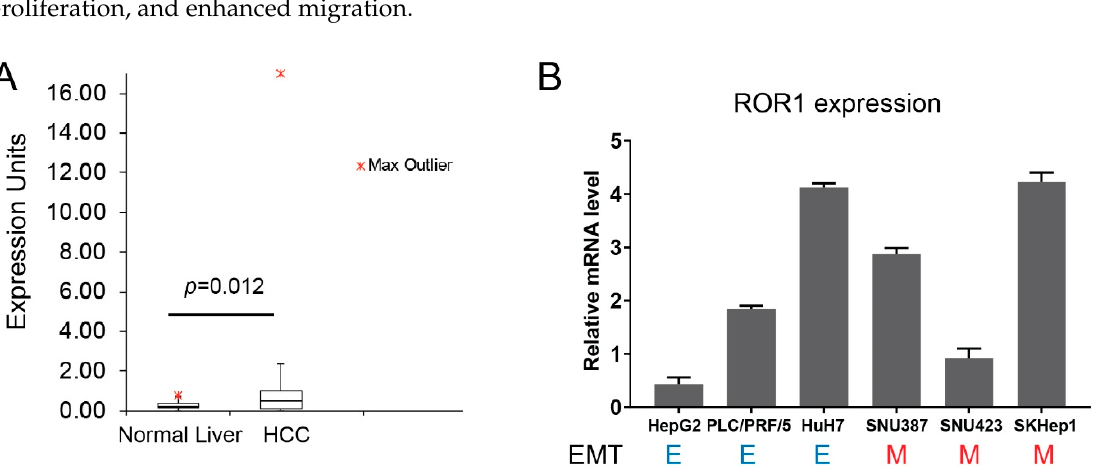
Figure 1. Detection of ROR1 expression in hepatocellular carcinoma (HCC) cells. ( A ) Gene expression of ROR1 in vivo. Box plot shows the expression of ROR1 in human HCC samples ( n = 99) as compared to normal liver tissues ( n = 52). Tumor tissues express significantly more ROR1 ( p = 0.012). ( B ) Expression of ROR1 in mRNA level was detected in HCC cells by RT-qPCR. ROR1 expression was calculated via normalization with GAPDH , and represented as a relative mRNA level. E: epithelial and M: mesenchymal.